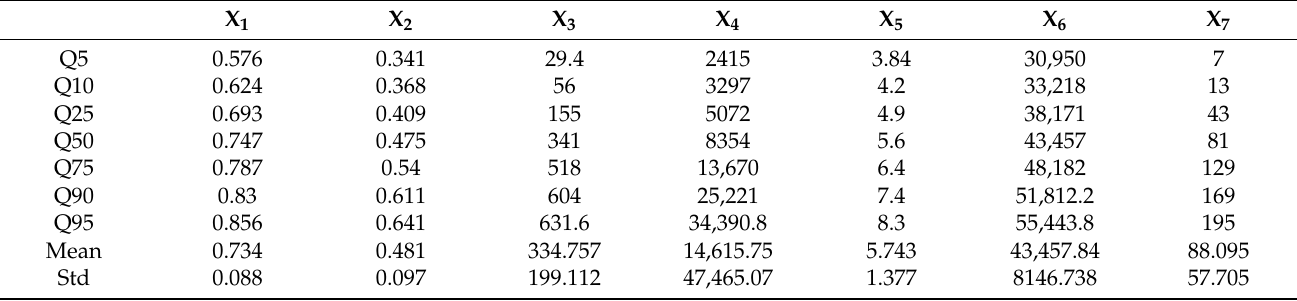
Table A3. Descriptive statistics for cluster 3.